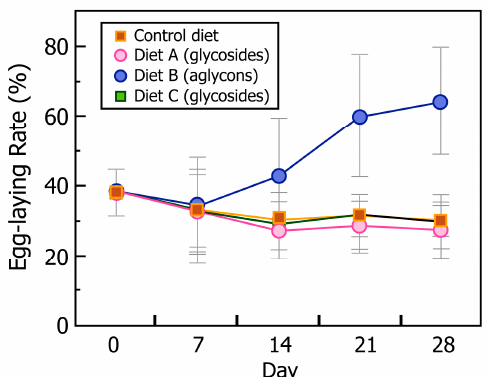
Figure 2. Graph showing the mean ± SD egg-laying efficiency of aging White Leghorn hens measured over a 28-d period for groups of hens fed a commercial corn/soymeal diet (Control), the same diet supplemented with soy germ to increase the isoflavone glycoside content (diet A), the same diet with added milled soy germ pasta containing predominantly isoflavone aglycons (diet B) and the same diet with added milled commercial pasta lacking isoflavones (diet C).